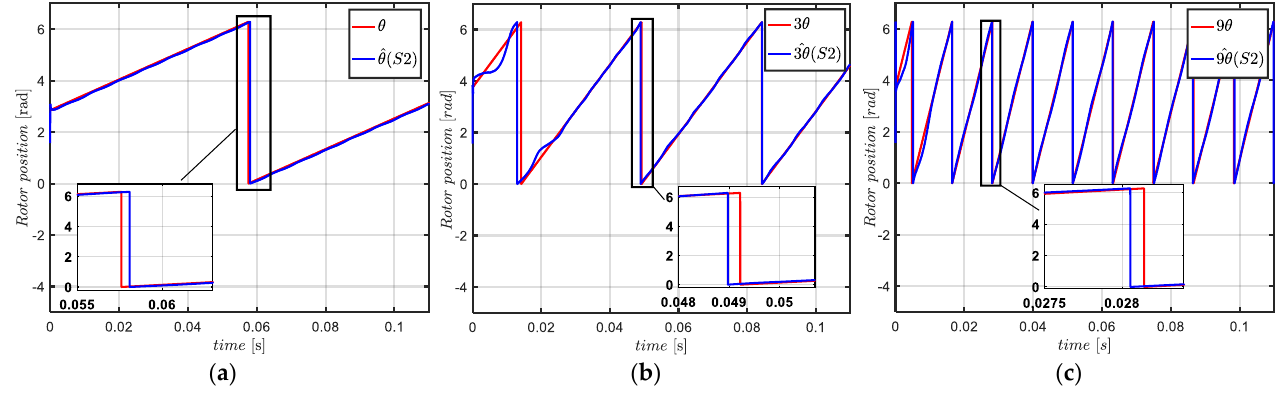
Figure 15. Simulation waveforms of actual and estimated rotor positions through ( S1 ) and ( S2 ): ( a ) angle required to control MM, ( b ) angle required to control SM, ( c ) angle required to control TM.